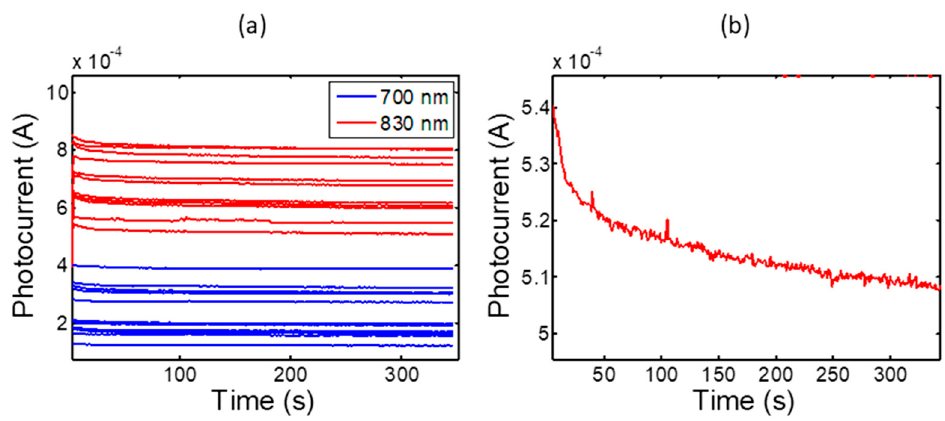
Figure 8. ( a ) Photocurrents (12 time traces for 830 nm light in red and 12 time traces for 700 nm light in blue) related to the fourth nearest-neighbor source-detector distance (SDS = 7.21 cm). ( b ) Detail: one of the photocurrent time traces related to 830 nm light.